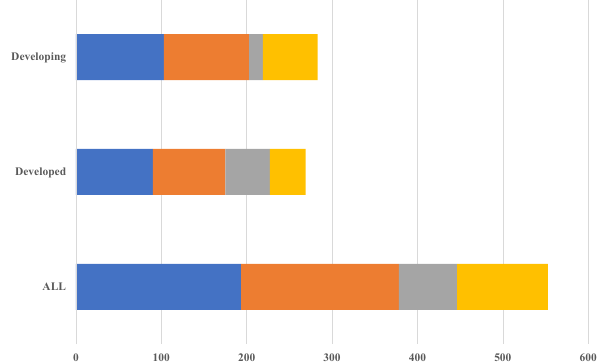
Table 2 GHG emissions (in CO 2 eq) from agriculture by commodity, 2014 (shares in